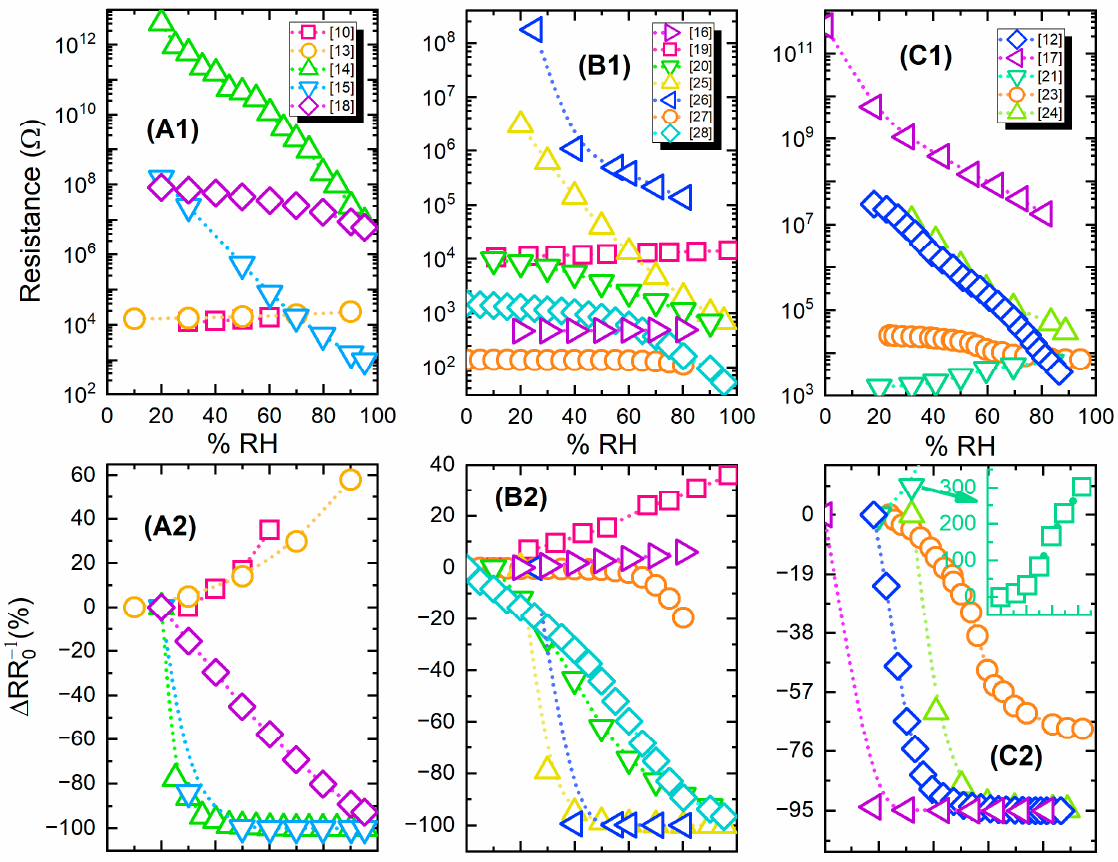
Figure 9. ( A1 – C1 ); Resistive humidity sensors response (resistance value) for different relative humidity levels; ( A2 – C2 ) relative percentage change for the same sensors. The graphs share the same legends and X axes per vertical couple, i.e., A1 & A2 have the same legend.